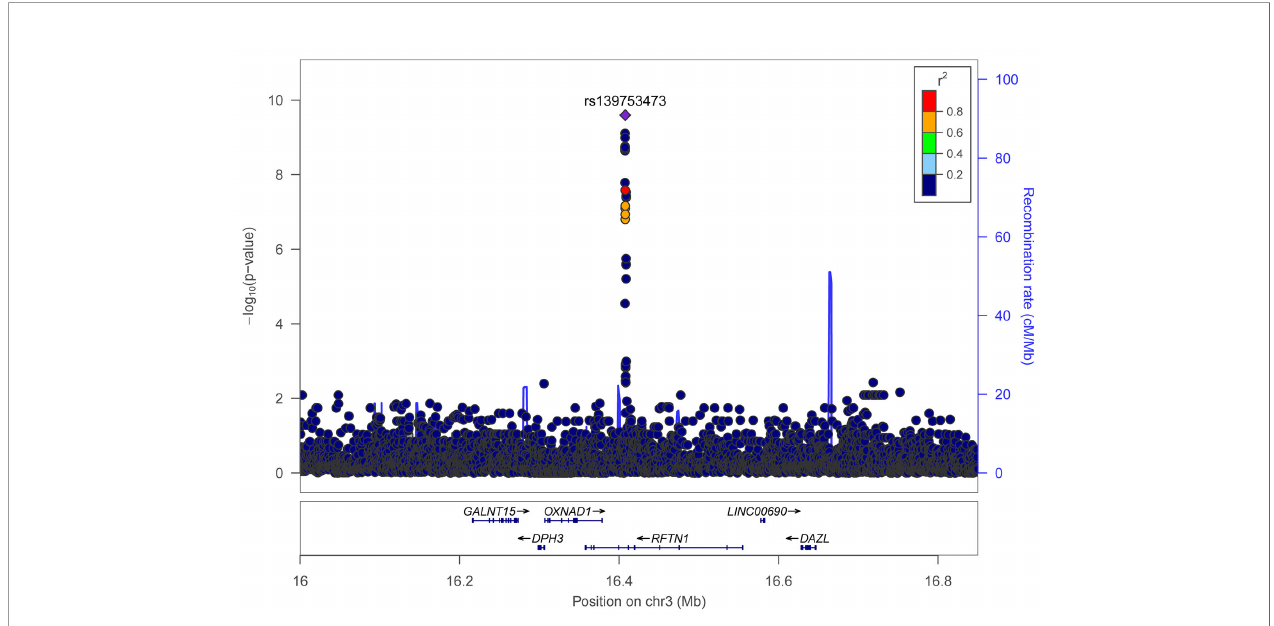
FIGURE 3 | Regional association plot for variants of the RFTN1 gene for smoking initiation. r 2 values were obtained from the hg19/1000 Genomes Nov 2014 ASN (Han Chinese and Japanese) samples. The plot was generated using LocusZoom (http://locuszoom.sph.umich.edu/).